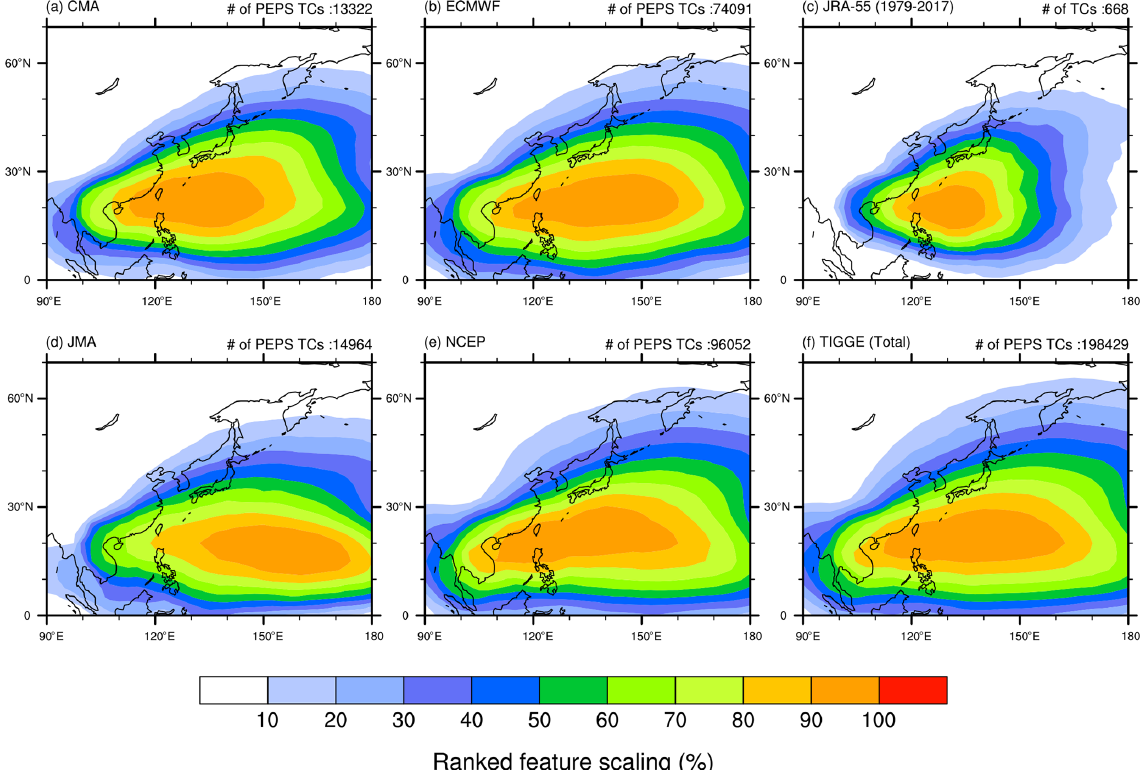
Figure 2. Ranked feature scaled track density (%) of different data sets: (a) CMA, (b) ECMWF, (c) JRA-55, (d) JMA, (e) NCEP, and (f) TIGGE total. The number of TCs in the corresponding event set is stated on the top right of each panel.